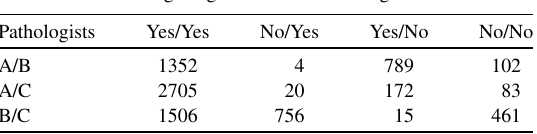
Pathologist agreement of mitotic figures Pathologists